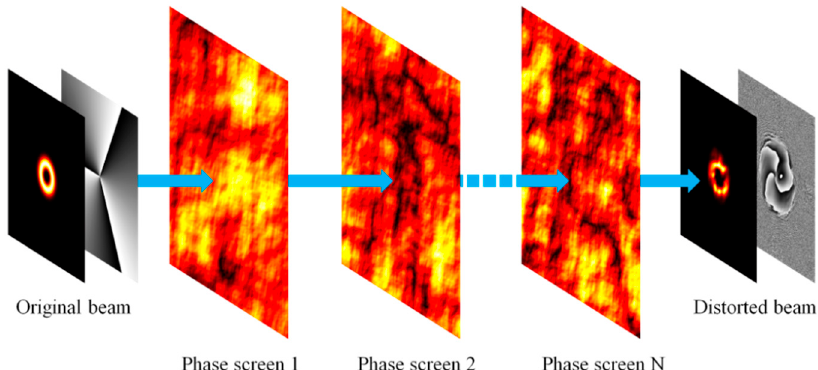
Figure 1. Schematic demonstration of atmospheric turbulence channel with N random phase screens. Δ The distance z between each screen is / Z N . ( Z : transmission distance; N : the number of sub-channels.)